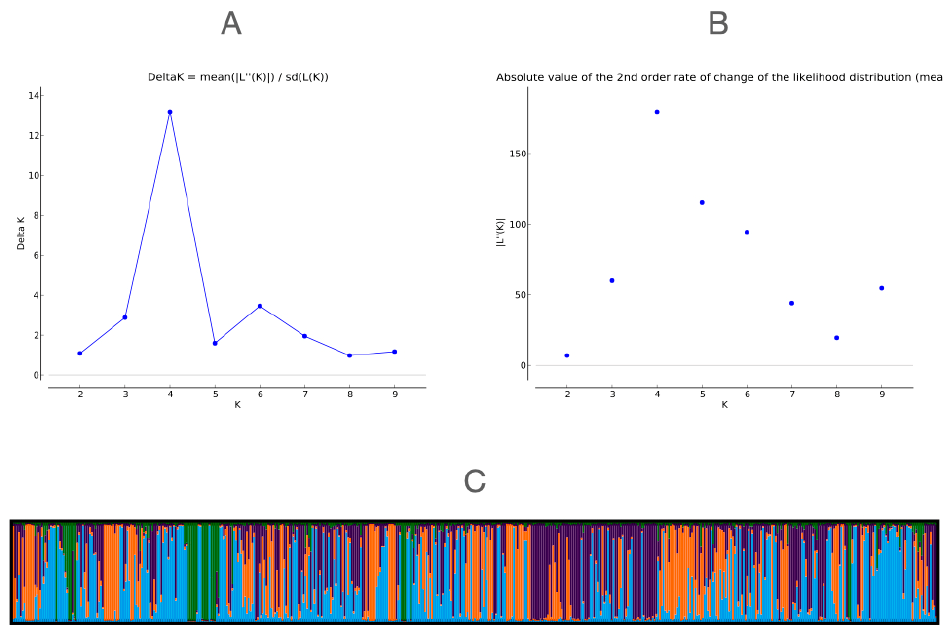
Figure 3. ( A ) Delta K values obtained with STRUCTURE HARVESTER. ( B ) Rate of change in the likelihood distribution (mean) obtained with STRUCTURE HARVESTER. ( C ) STRUCTURE software clustering at K = 4 on a dataset containing 519 individuals.